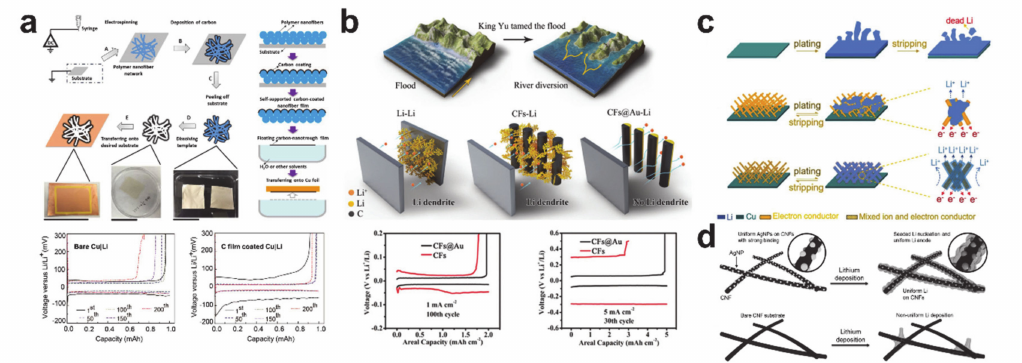
Figure 23. Nanofibrous lithium metal hosts and their electrochemical performances. ( a ) Semi-tubular carbon film (reprinted with permission from [250]; copyright 2017 Elsevier), ( b ) gold-coated carbon nanofiber (reprinted with permission from [251]; copyright 2018 John Wiley and Sons), ( c ) Li 6.4 La 3 Zr 2 Al 0.2 O 12 nanoparticle incorporated carbon nanofiber (reprinted with permission from [252]; copyright 2018 John Wiley and Sons), and ( d ) silver nanoparticles decorated carbon nanofiber (reprinted with permission from [253]; copyright 2017 John Wiley and